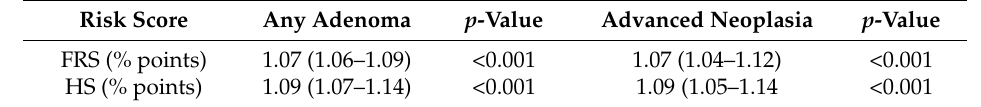
Table 3. Risk of any adenoma and advanced neoplasia, by one percentage point increases in the risk scores, in subjects without known